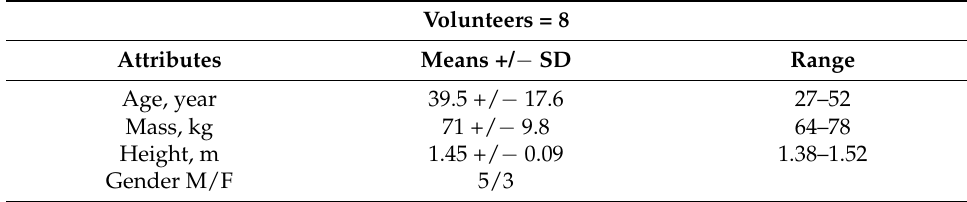
Table 1. Volunteers’ physical attributes.